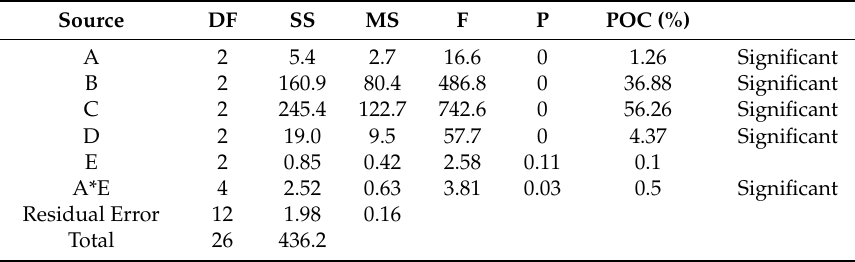
Table 8. S/N ratio analysis for cutting force obtained.